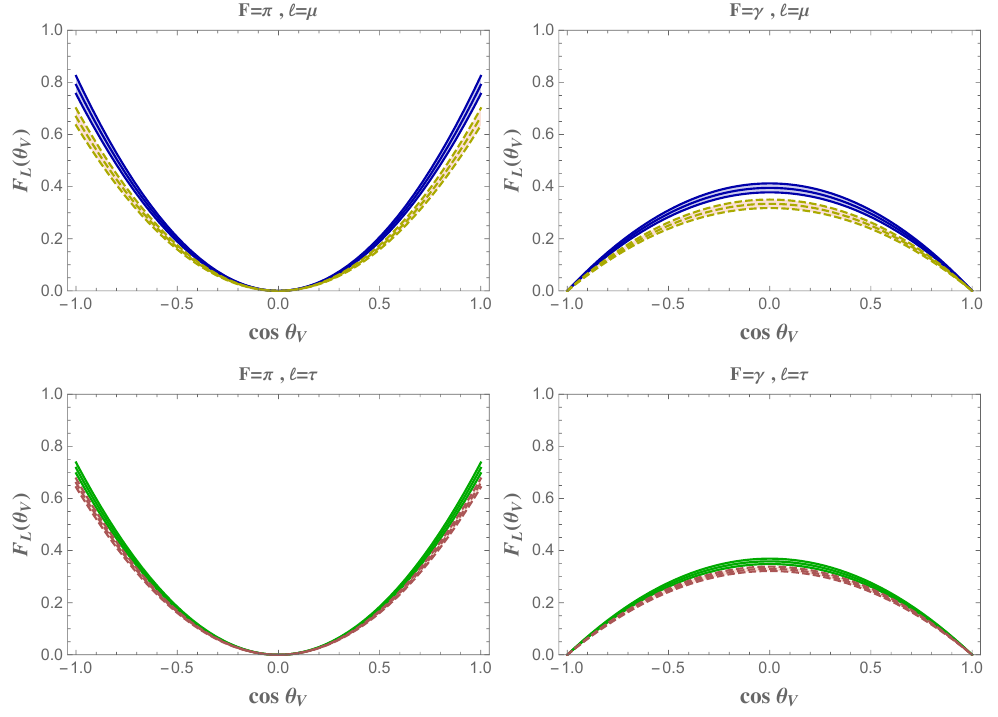
Figure 14 . Distribution F L ( (cid:18) V ). The upper and lower plots refer to ‘ = (cid:22) and ‘ = (cid:28) , the left and right column to F = (cid:25) and F = (cid:13) . The continuous lines show the SM result, the dashed lines the NP result at the benchmark point ~ (cid:15) ‘ . T